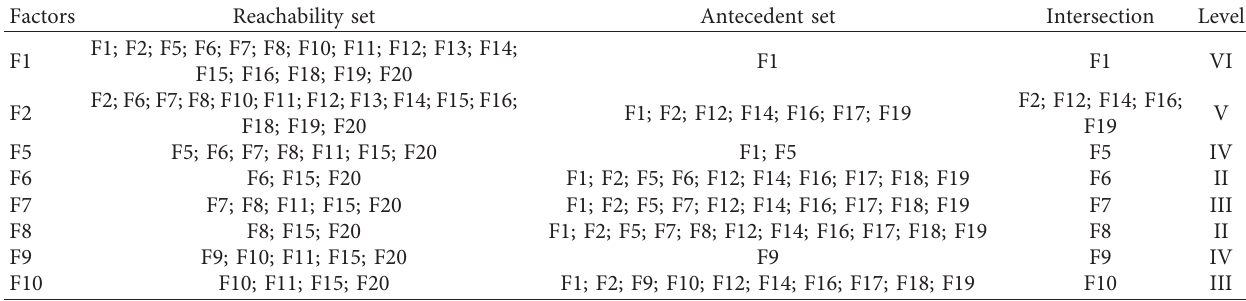
Table 6: Results of grouping